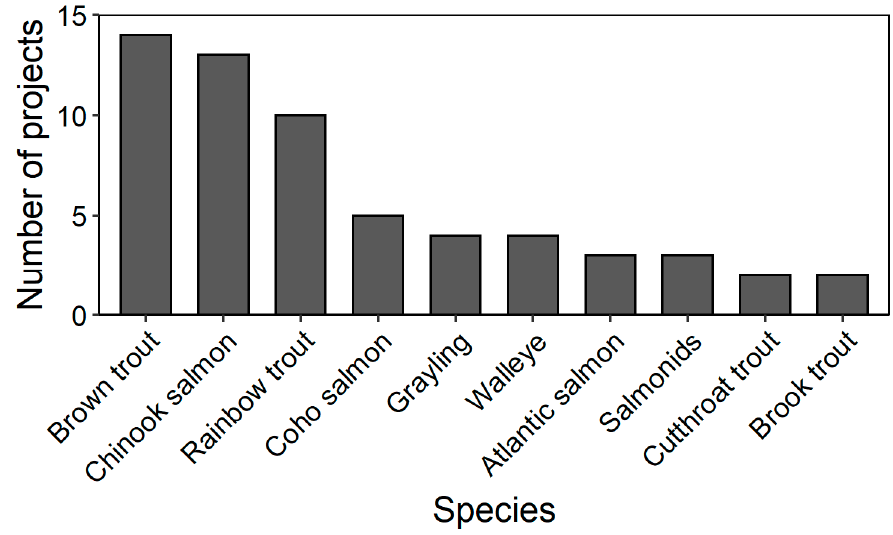
Figure 4. Most common fish taxa ( n = 10 of 26 total taxa) targeted by rocky spawning habitat maintenance projects. “Salmonids” represents studies where a target species of salmonid was not identified. Note that each project may have targeted more than one focus species.